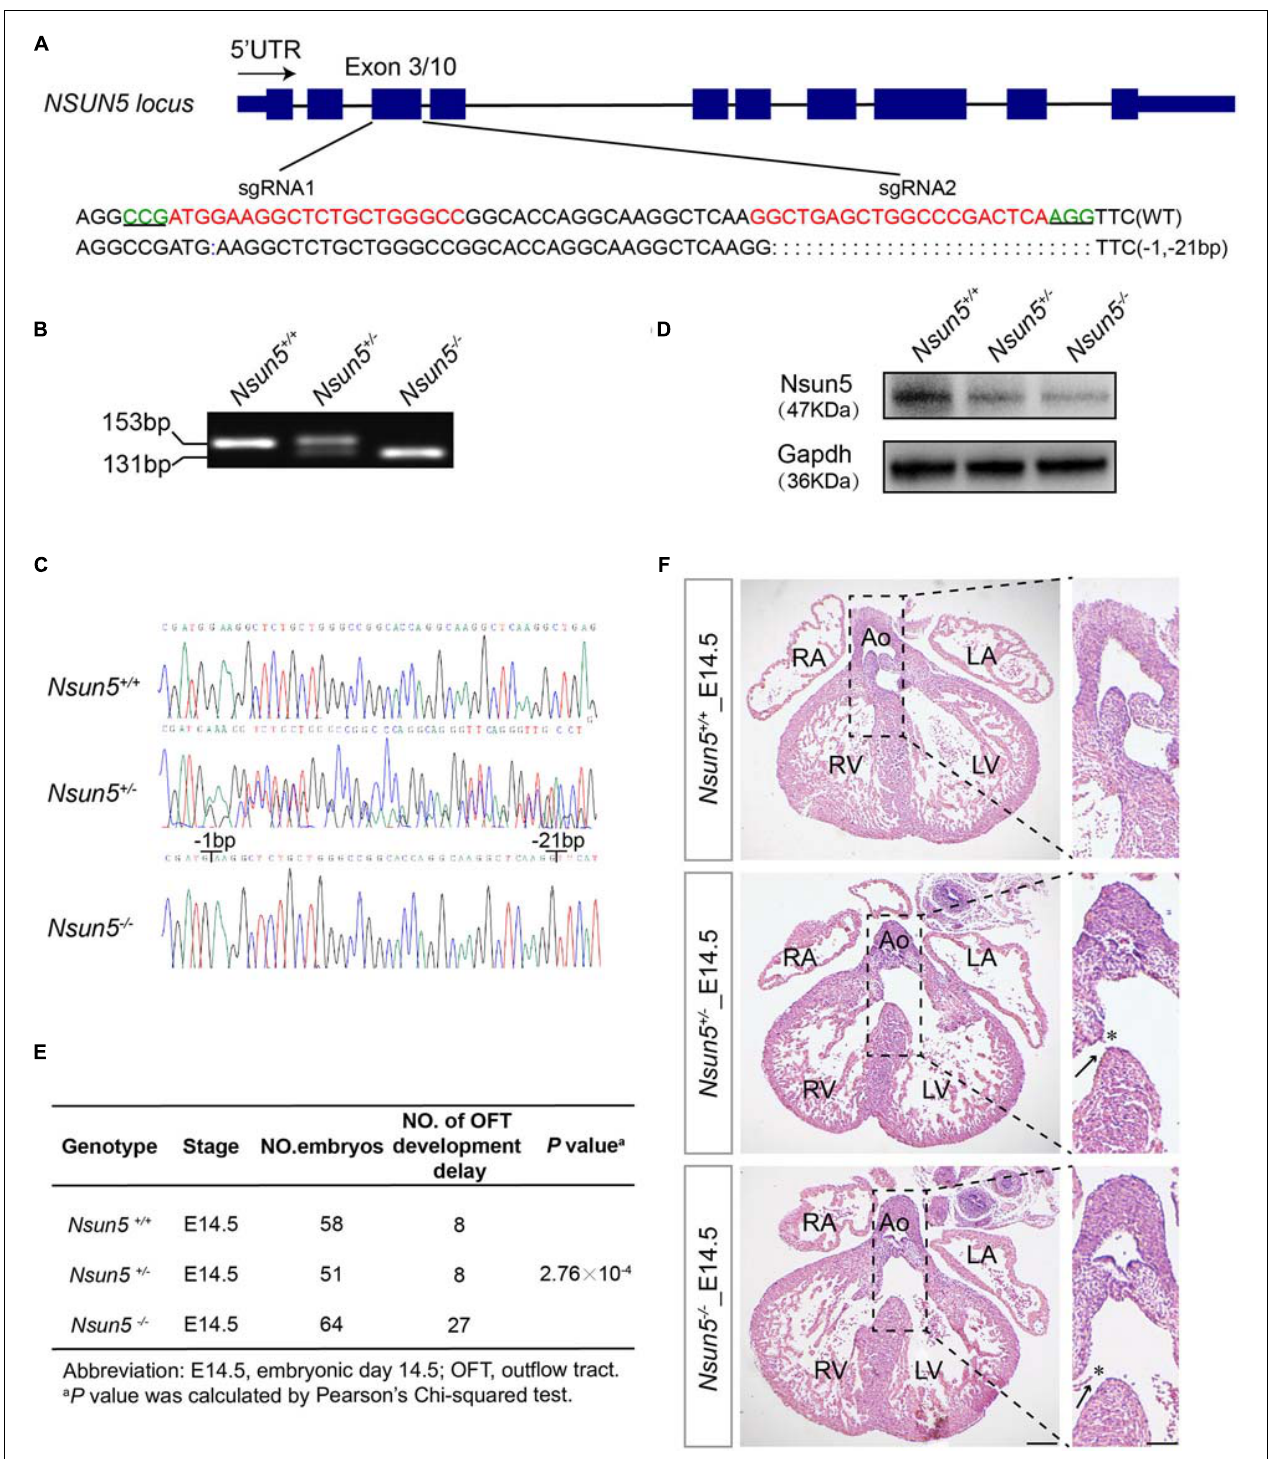
FIGURE 2 | Characterization of Nsun5 knockout mouse model and OFT septation development delay shown in Nsun5 absent mice. (A) Two sgRNAs designed to target Exon3 of Nsun5 gene. The PAM sequences were highlighted in green and the sgRNAs sequences were highlighted in red. (B) Genotype identification of offspring mice derived from founder mouse with 22-bp deletion. Nsun5 DNA were from tail biopsies of wild-type (+/+), heterozygous ( ± ) and homozygous (–/–). (C) Sanger sequencing verification of offspring mice. (D) Western blot analysis of Nsun5 in mouse heart tissue protein extracted at E14.5. (E) Frequency analysis of OFT development delay in E14.5 embryo hearts. (F) Representative H&E staining of E14.5 hearts. Nsun5 + / − and Nsun5 - / - mice E14.5 hearts clearly showed OFT aorta misalignment (asterisk) and septation defect (arrow). Scale bar = 100 or 50 µ m. Pearson’s Chi-squared test was used for statistical calculation.